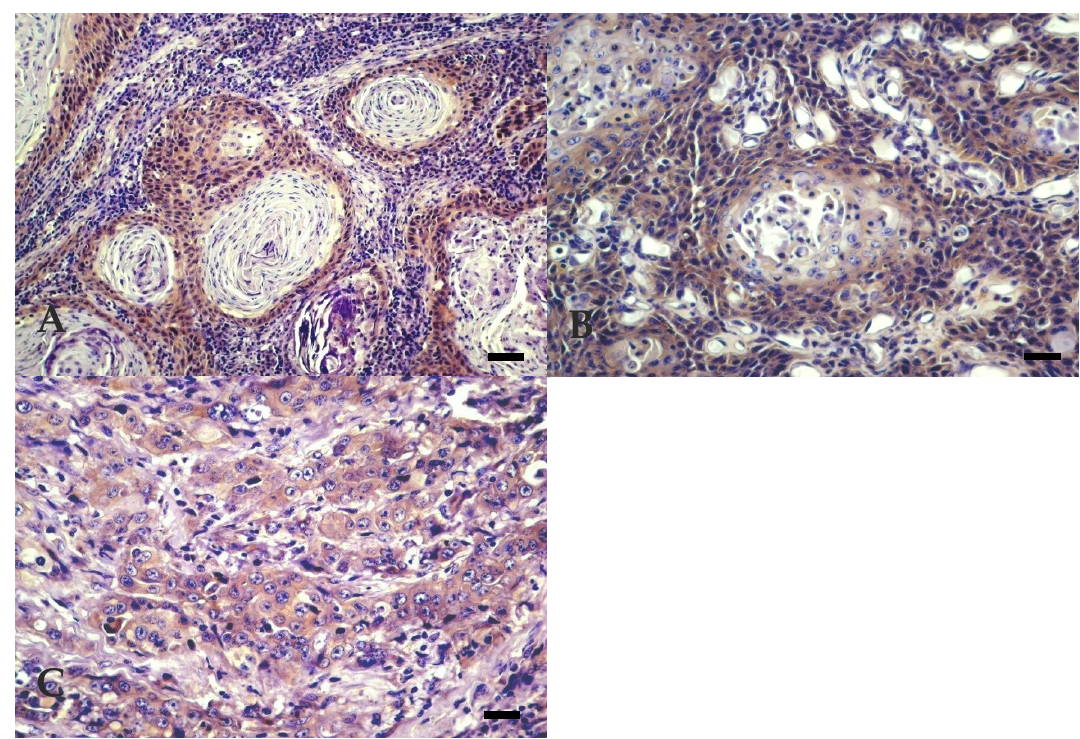
Figure 5. Expression of profilaggrin in BOSCC. ( A ) WD: granular cytoplasmatic and intense reaction, observed in all cellular types, including basal ‐ like cells. Bar, 50 μ m. ( B ) MD: granular cytoplasmatic and intense reaction in all cellular types, including basal ‐ like cells. Bar, 25 μ m. ( C ) PD: unspecific granular cytoplasmatic reaction observed in all cellular types, including basal ‐ like cells. Bar, 25 μ m. Immunohistochemistry using avidin ‐ biotin complex method, Mayer’s Hematoxylin counterstain.